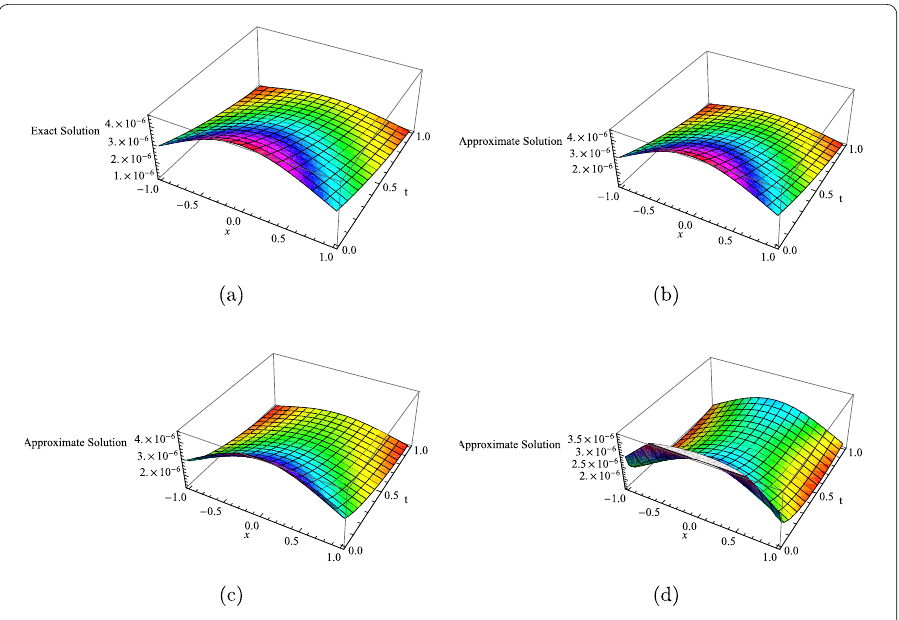
Figure 9 The surface graph of the exact solution u ( x , t ) and the seventh-order approximate solution u 7 ( x , t ) of Eq. (4.8): ( a ) u ( x , t ) when λ = 1, ( b ) u 7 ( x , t ) when λ = 1, ( c ) u 7 ( x , t ) when λ = 0.75, ( d ) u 7 ( x , t ) when λ = 0.5